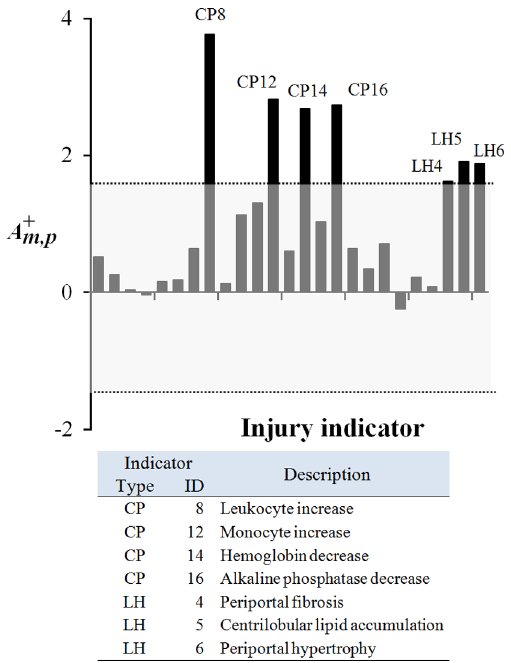
Figure 7. Module 55 activation across the 25 injury indicators. Activations shown represent the 25 injury indicators in Table 1 . Labeled peaks represent a module 55 activation score A z 1.5 as calculated using Equation (8). CP, clinical pathology; LH, liver histopathology.